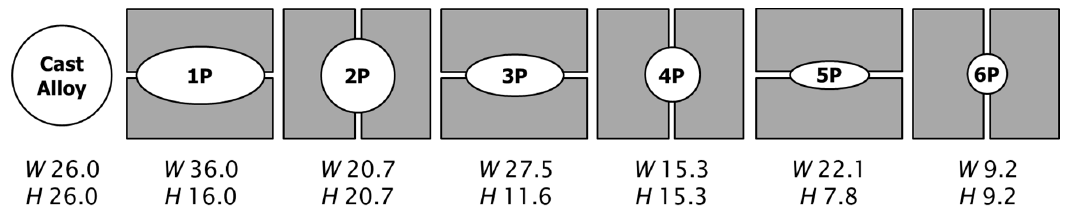
Figure 1. Changes in the cross-sectional area of the caliber-rolled Mg alloy specimens depending on the rolling pass. The gray area indicates a pair of rolls. W and H are the width and height of the cross-sectional area, respectively (unit: mm).